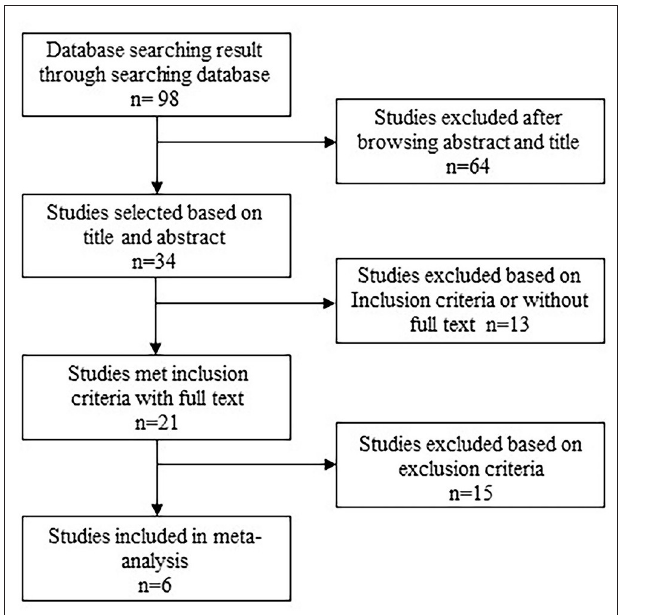
FIGURE 1 | Flowchart showing selection of studies included in the